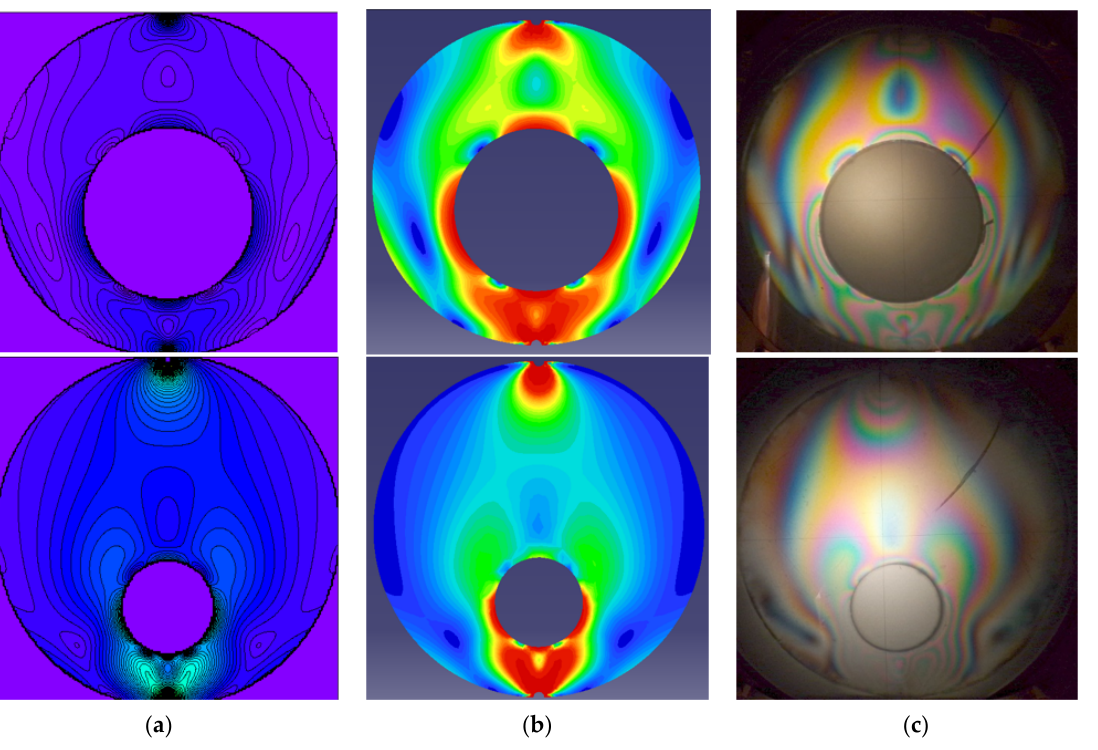
Figure 15. Isochromatic fields for two geometries of the ring compressed in the direction of the centres (loading Case a , Table 1): theoretical ( a ), numerical ( b ) and experimental ( c ) results.